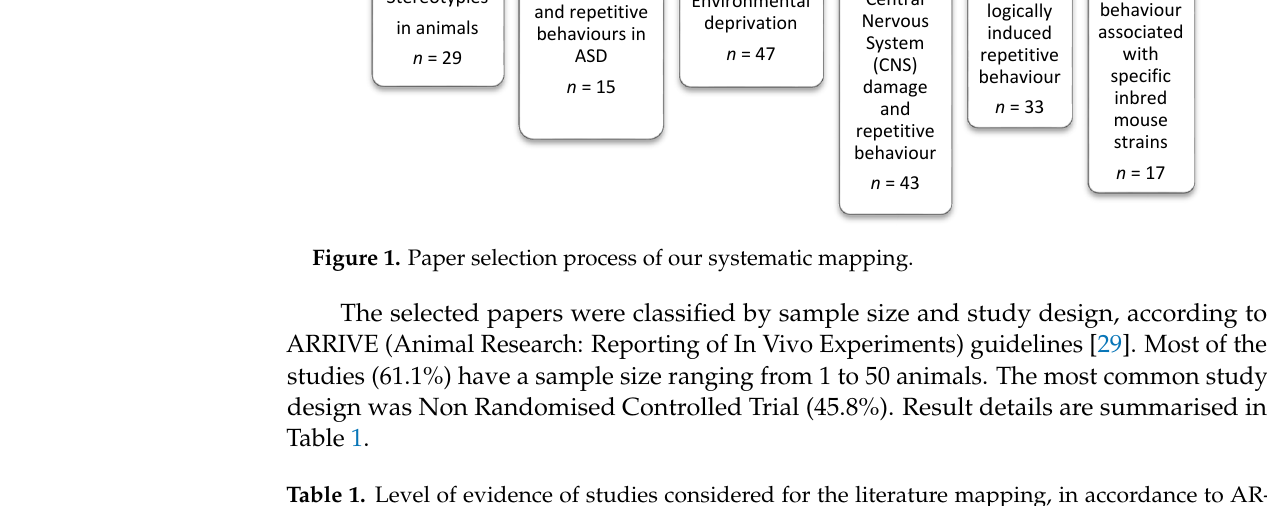
Table 1. Level of evidence of studies considered for the literature mapping, in accordance to AR- RIVE